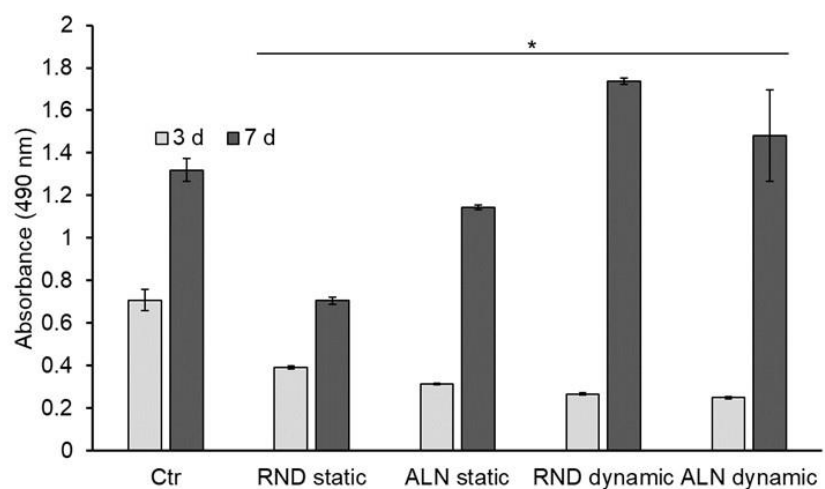
Figure 6. Endothelial cells viability assay. MTS assay was performed after three and 7seven days of culture on static and dynamic samples. Data are expressed as mean values ± SD. ( n = 3, * p ≤ 0.05 with respect to control) .